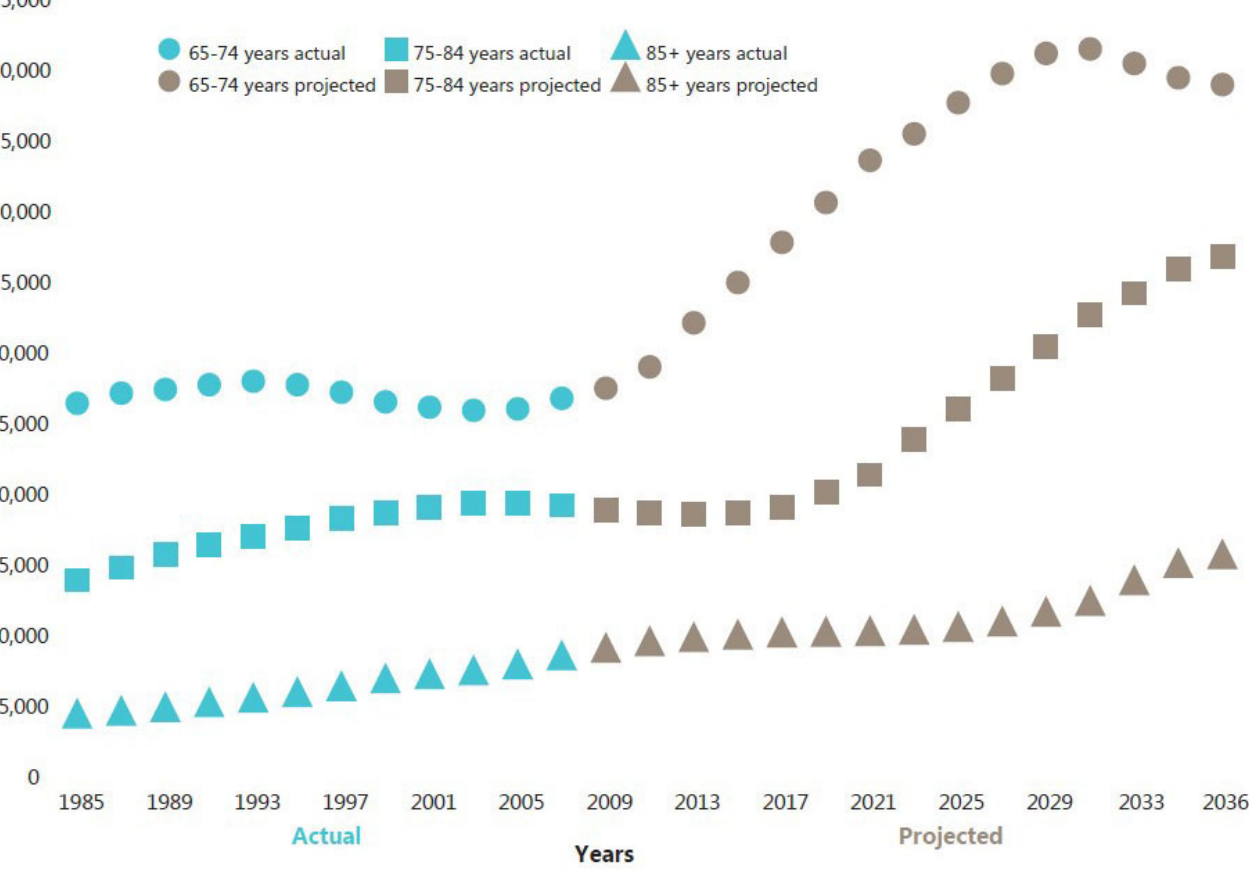
Figure from Chateau et al. (2012) – used with permission. Population projections calculated by Manitoba Bureau of Statistics